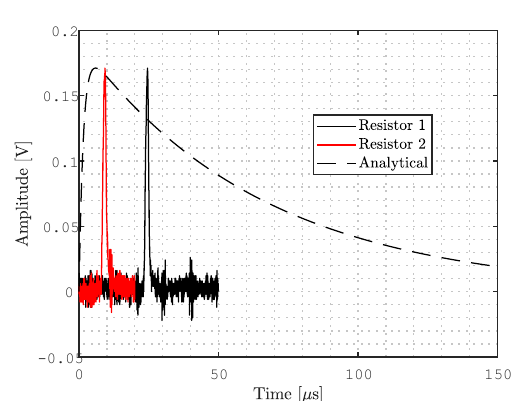
FIGURE 10. Measured induced voltages at both load resistors.